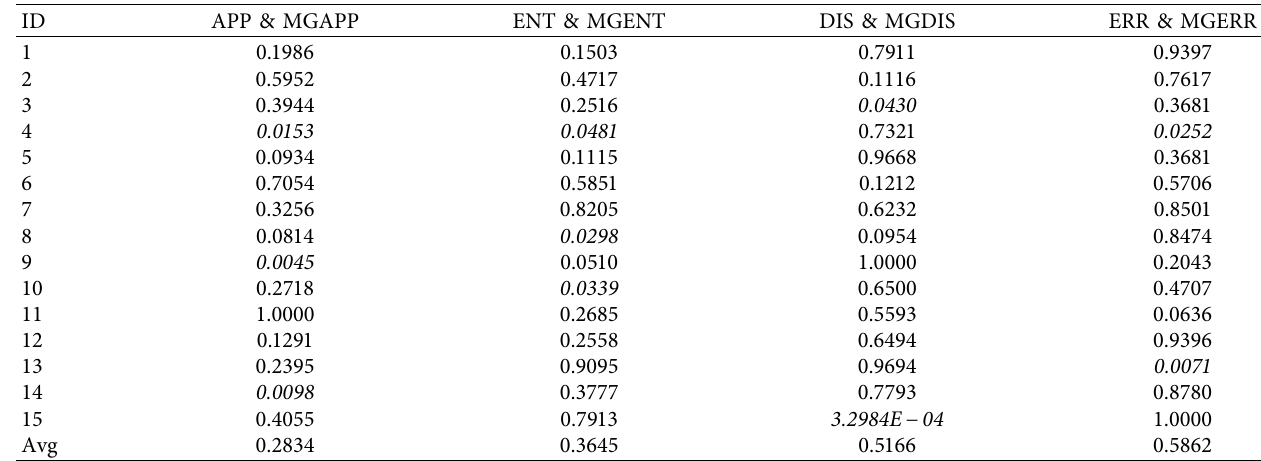
Table 6: Comparisons of the distributions with